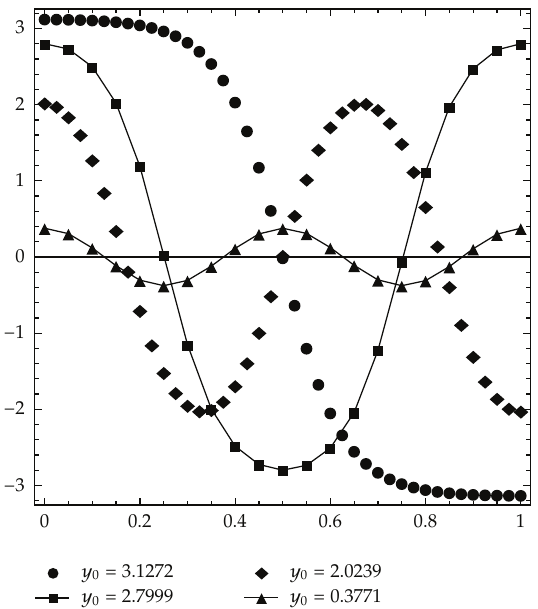
Figure 6: Solution of (cid:2) 1.2 (cid:3) corresponding to the initial values y 0 for 16 π 2 ≤ λ (cid:5) 160 < 25 π 2